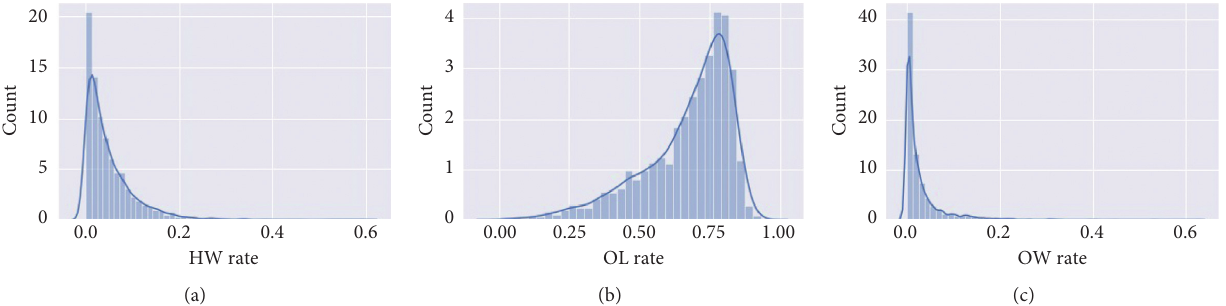
Figure 2: Distributions of three rates of jobs-housing attributes. (a) Distribution of HW rate. (b) Distribution of OL rate. (c) Distribution of OW rate.